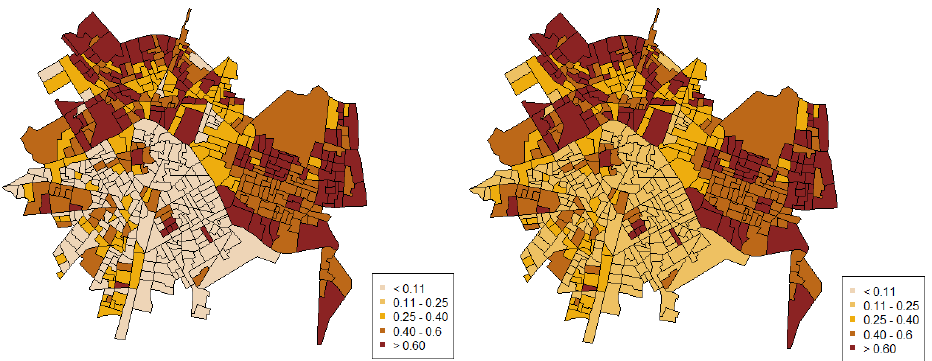
Figure 5. Map of the first ( left ) and the third ( right ) quartile of the posterior mean level of drug-related police interventions.